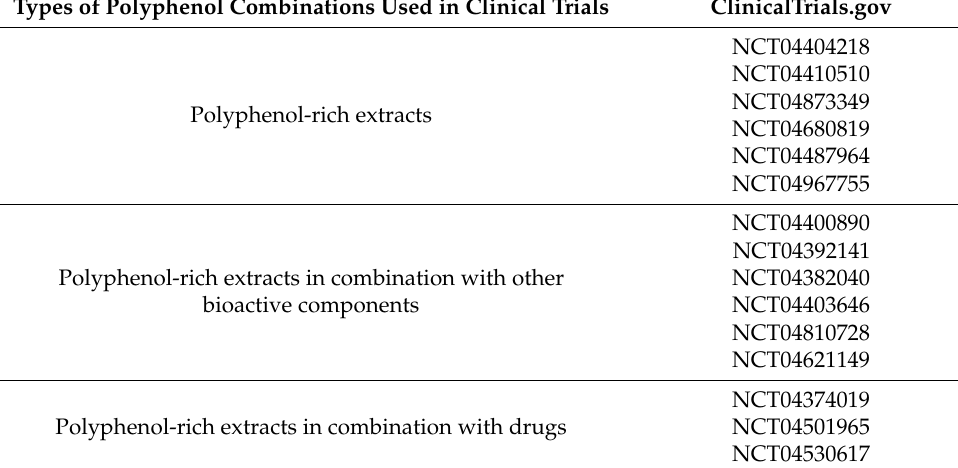
Table 1. Cont. Types of Polyphenol Combinations Used in Clinical Trials ClinicalTrials.gov